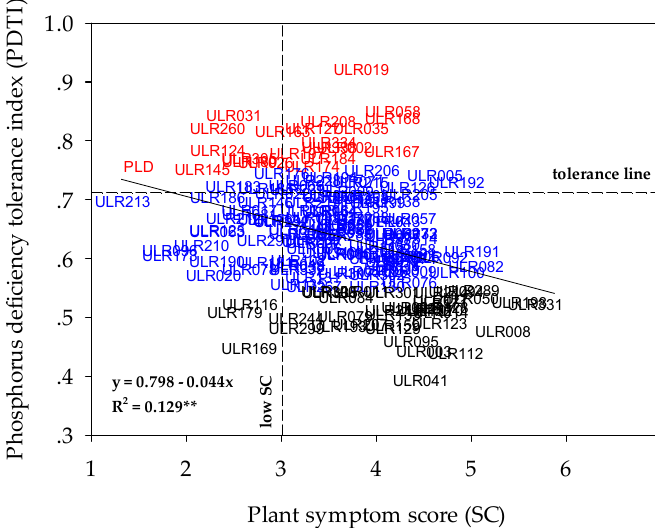
Figure 3. The relationship between plant symptom score (SC) and phosphorus deficiency tolerance index (PDTI) of 168 indigenous upland rice genotypes; red = Group 1, blue = Group 2, and black = Group 3.